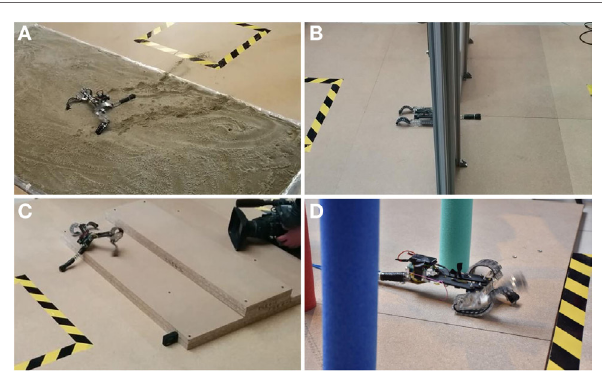
FigUre 8 | robot during the robosoft competition: (a) task 1 – sand; (B) task 2 – aperture; (c) task 3 – stairs; (D) task 4 – unstable elements